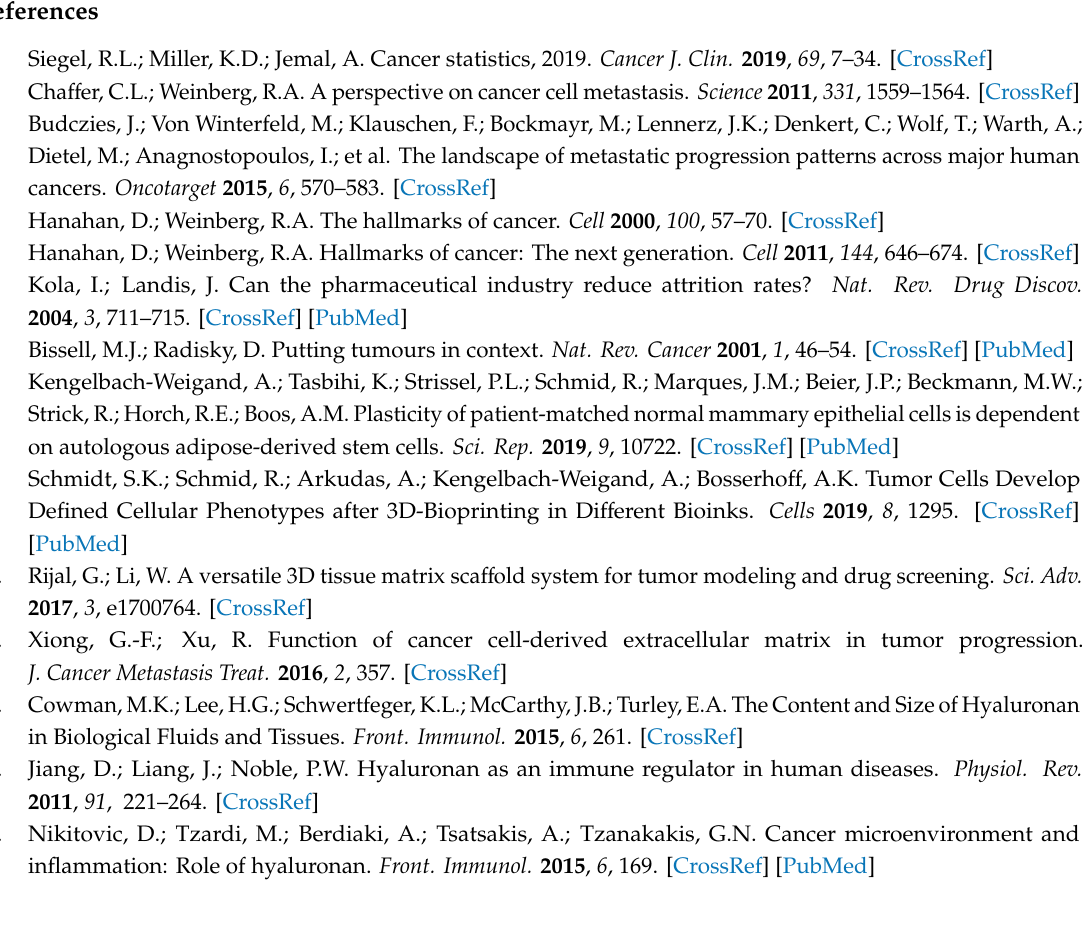
Figure S1: Exemplary pictures of the Apoptotic / Necrotic / Healthy Staining showing the individual